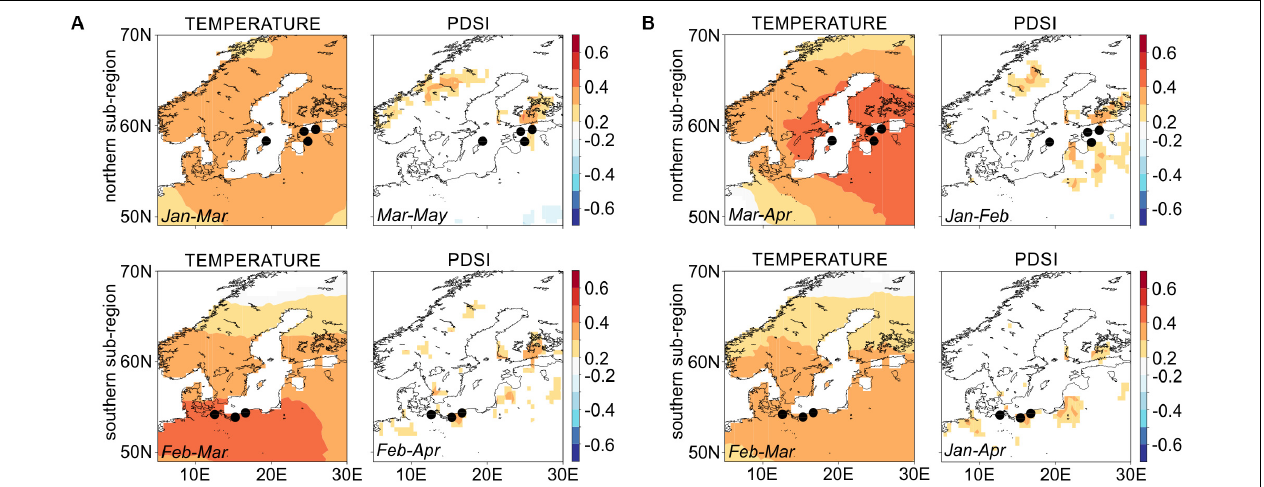
FIGURE 3 | Spatial Pearson’s correlation maps for northern and southern sub-regions’ chronologies for (A) ring-width and (B) latewood blue intensity against winter-spring temperature and drought variables (see inset text in each panel for climate season). Dots representing sites GA and GB as well as UA and UB overlap each other due to the small distance between sites (see the detailed location of each site on Figure 1 ). Correlations are based on the 1903–2016 common period. Dots correspond to tree-ring sites presented on the Figure 1 and in Table 1 . White color within lands’ borders represents non-significant values of correlations.